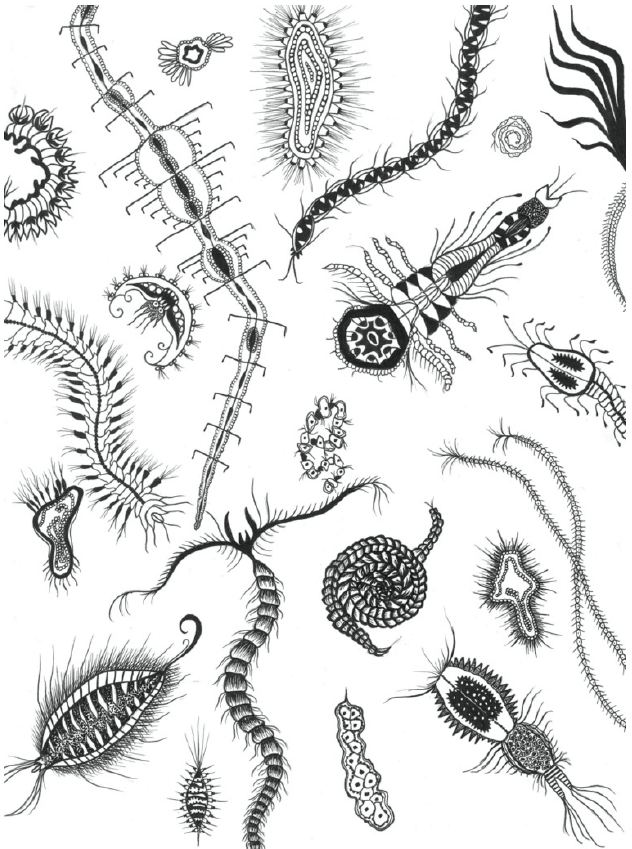
Figure 2. Susan Stanton (PSU ’15, and a student in the visualization class). “Bugs,” after a passage of Secret Essential Methods for Curing Meditation Illness . Ink on paper, completed after the class finished in 2019.